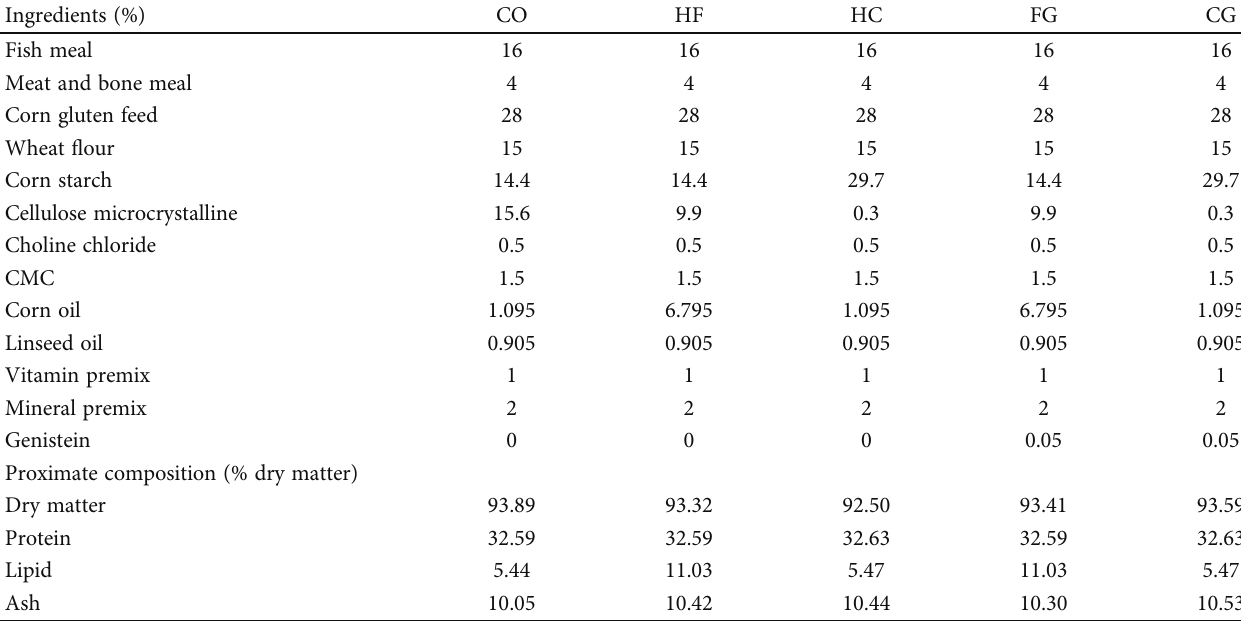
Table 1: Ingredient and proximate analysis of experimental diets